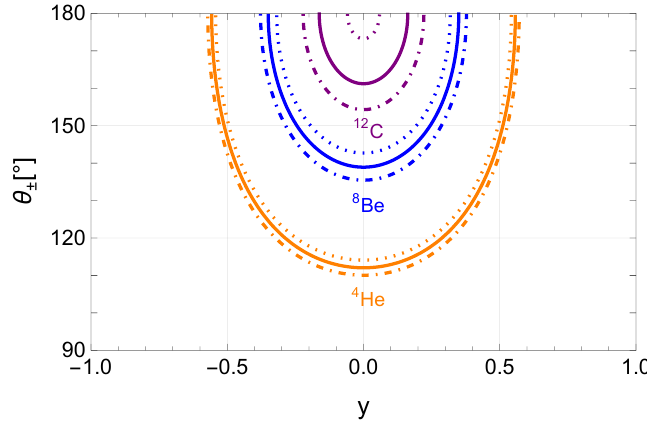
Figure 1 . Values of the e + e − opening angle θ ± as a function of the energy asymmetry y for three values of the boson mass: m = 16 . 8 MeV (dot-dashed line), m = 17 MeV (solid line) and X X m X = 17 . 2 MeV (dotted line) for the cases of the 8 Be, 4 He and 12 C